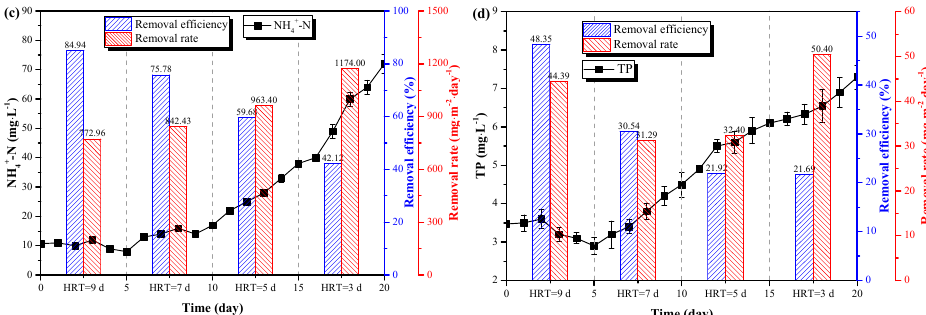
Figure 5. The results of pretreated pig urine treatment under di ff erent HRT. ( a ) The variations of C. vulgaris biomass density and production. ( b ) the variations of C. vulgaris chlorophyll fluorescence parameters. The variations of NH 4 + -N ( c ) and TP ( d ) concentrations, removal e ffi ciencies and removal rates.